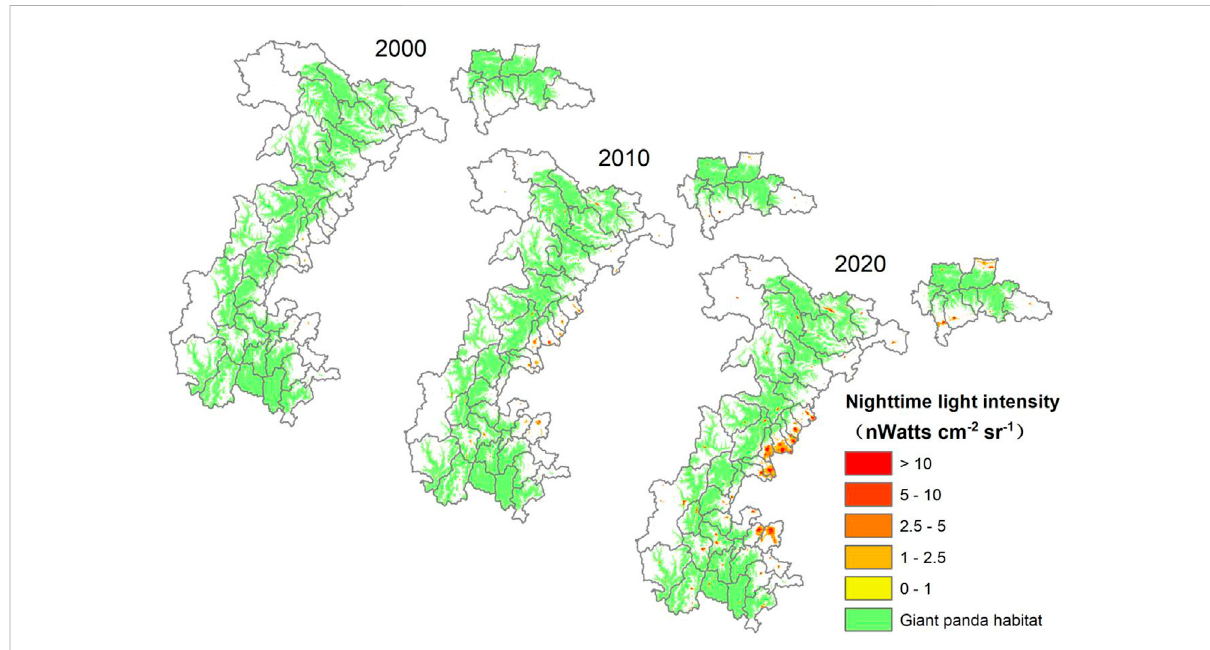
FIGURE 3 Spatial patterns of nighttime light intensity in giant panda distribution area (2000, 2010, and 2020).